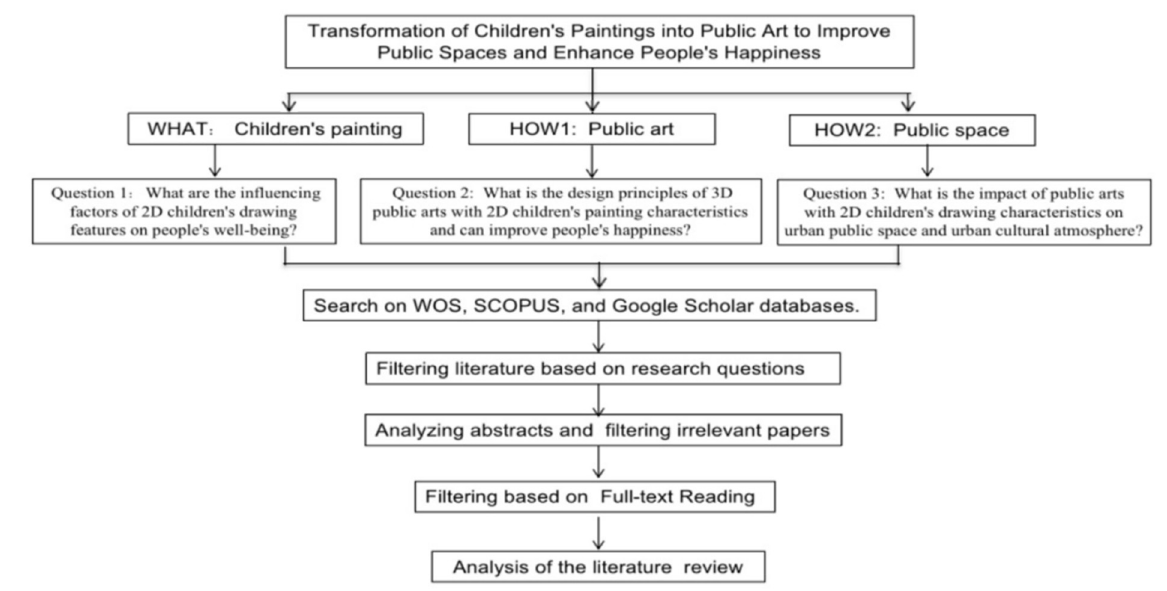
Figure 1. The workflow of the systematic literature review synthesis process adapted with permis- sion [9]. Copyright 2018, Ibrahim and Mustafa Kamal.